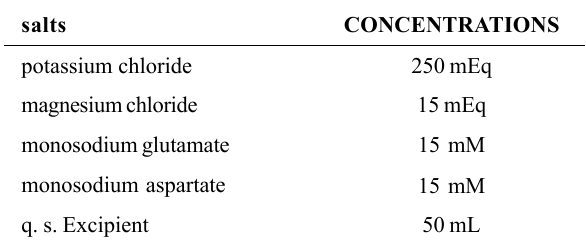
Table 3. Stock solution for maintenance-reperfusion of low- volume cardioplegia.